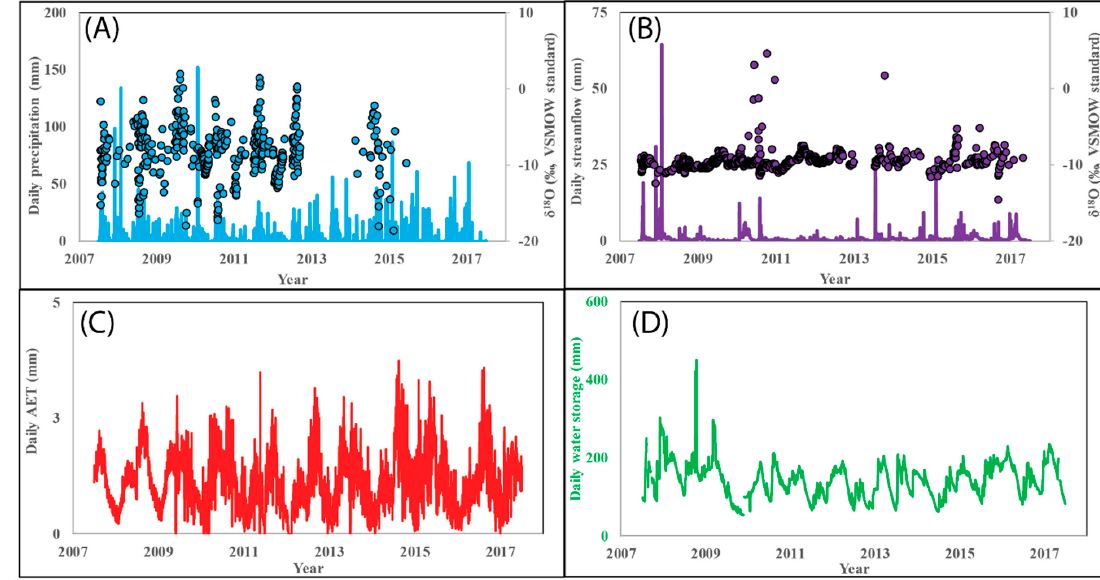
Figure 2. Catchment-scale hydrological fluxes and storages through time. ( A ) Daily precipitation (bars) and precipitation δ 18 O (points), ( B ) daily streamflow (bars) and stream water δ 18 O (points), ( C ) daily actual evapotranspiration (AET), and ( D ) daily soil water storage from water year 2008 through 2017.